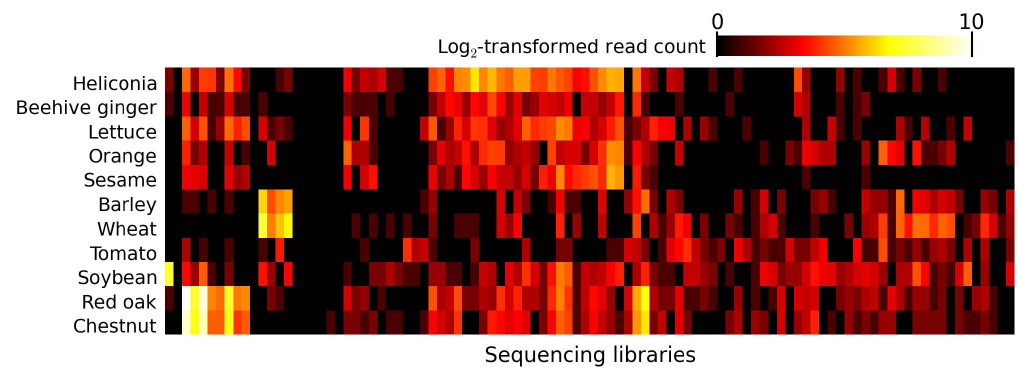
Figure 4. Heterogeneous species appear to contaminant samples from the same tissue and experiment. The ‘‘Tumor’’ [23] experiment dissociated 100 individual cells from a sample of a single tumor and sequenced libraries from each. Following the analysis pipeline of a study that claimed to find different plant species in different blood plasma samples from a single experiment, I used bowtie to screen each read in each library against the human reference genome before using it to query a database of chloroplast genomes. The number of such hits to each genome is depicted here, each count incremented by one and log-transformed. Only chloroplast genomes with at least 200 hits are shown. Rows and columns were clustered using a neighbor-joining algorithm.